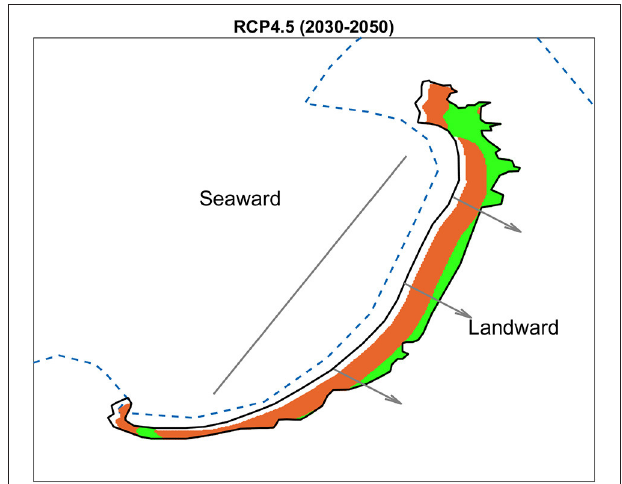
FIGURE 6 | Example of the beach area calculation under future conditions. The coastline is represented (blue dashed line) along with the mean coastline orientation (grey line). The arrows indicate the direction towards which the coastline retreats. The dry beach area is plotted for present conditions (black contour), under future mean conditions (orange area) and under future extreme conditions (green